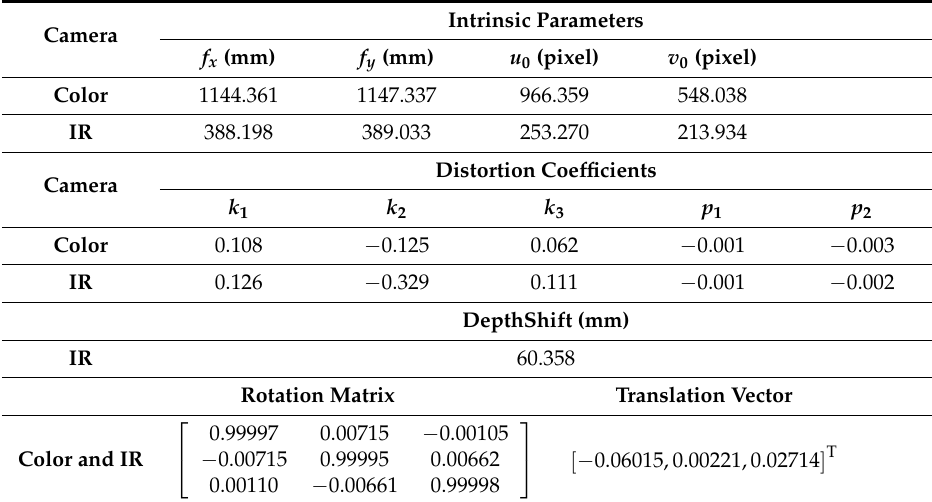
Table 5. Parameters from the calibration of the Kinect v2 (by rounding).